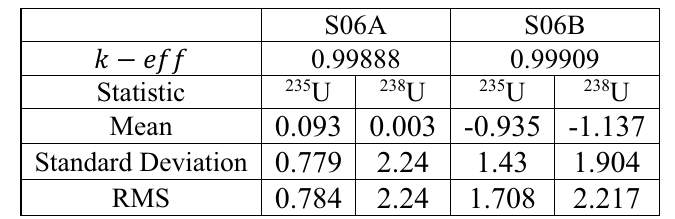
Table IV. CASMO5 DIMPLE critical experiments : k–eff and fission rate (relative difference